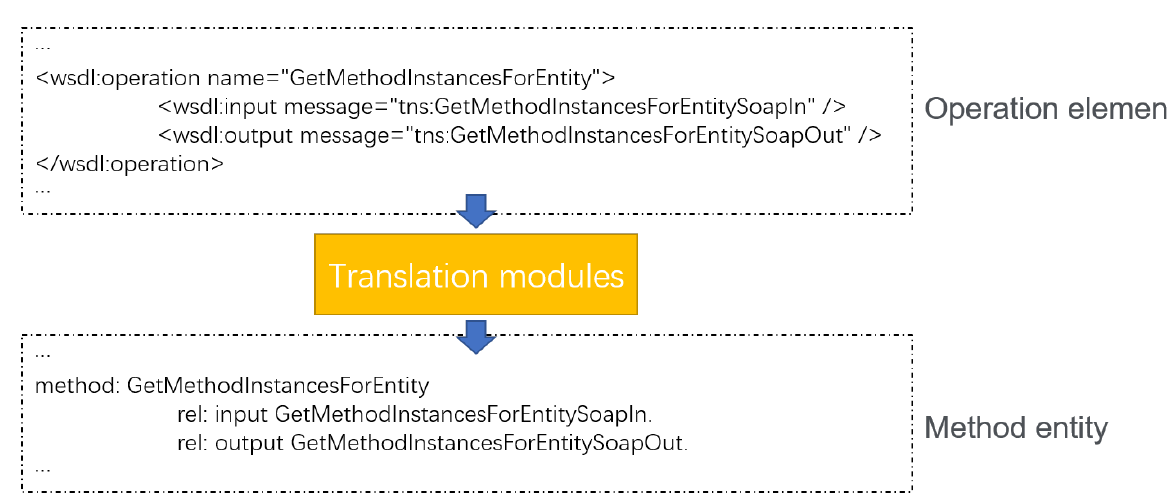
Figure 4. An example of converting the operation information stored in WSDL into a method entity.